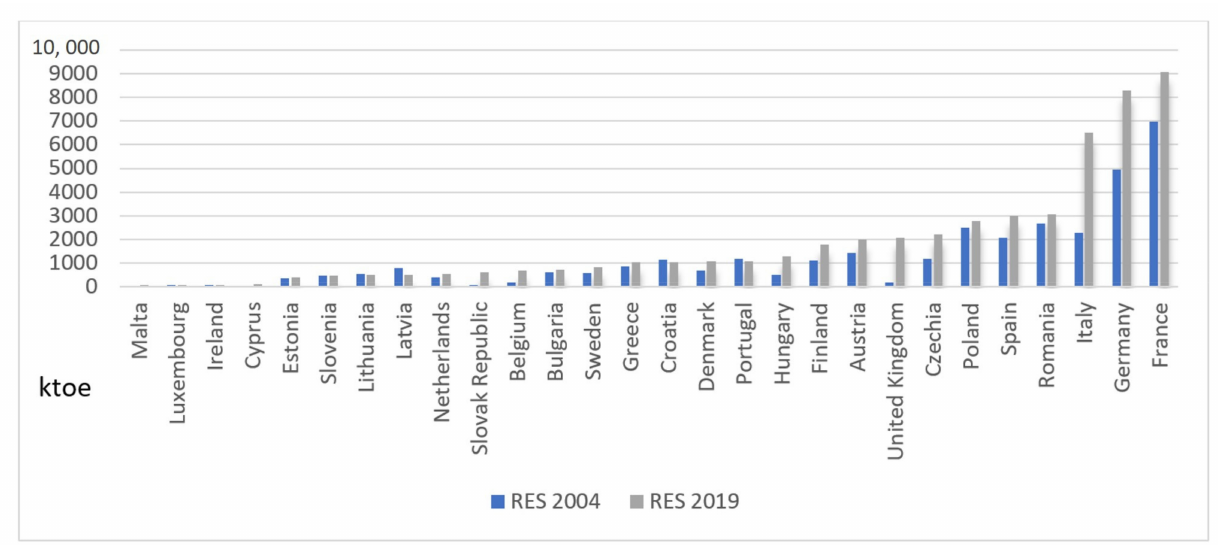
Figure 3. Energy from RES in EU households in 2004 and 2019, in thousands of tons of oil equivalent. Source: own elaboration based on data from